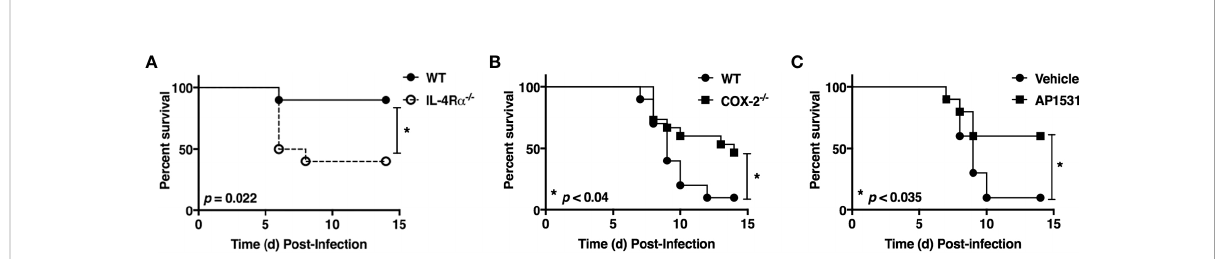
FIGURE 1 Opposing action of M2 vs. M1 macrophage activation on in fl uenza (PR8)-induced lethality. (A) WT BALB/cByJ and IL-4R a -/- mice were infected i.n. on day 0 with ~1500 TCID 50 A/PR/8/34 (PR8) (LD 10 ) and survival was followed for 14 days. N = 10 mice/strain from 2 experiments. (B) WT C57BL/6J and COX2 -/- mice were infected i.n. on day 0 with ~7500 TCID 50 PR8 (LD 90 ) and survival was followed for 14 days. N = 15 mice/strain from 3 experiments. (C) WT C57BL/6J mice were infected with ~7500 TCID 50 PR8 (LD 90 ) on day 0 and then treated i.v. with vehicle or AP1531 (180 mg/mouse) daily from days 2-6 p.i. and survival was followed for 14 days. N = 10 mice/treatment from 2 separate experiments. Survival data was analyzed by the Mantel-Cox log rank